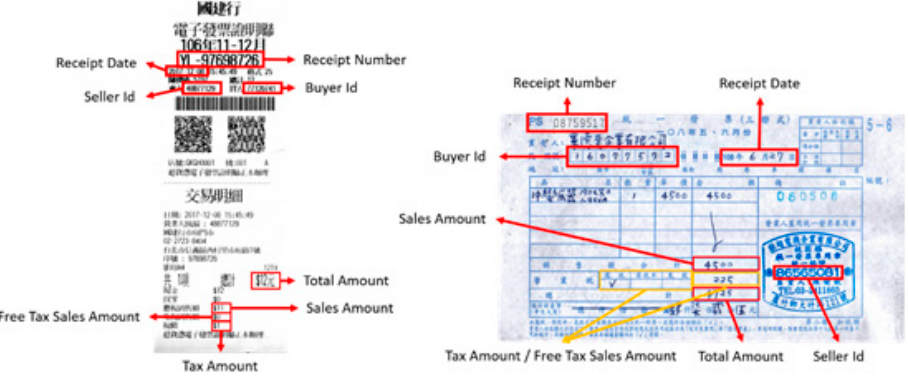
Figure 10. Receipt information required for tax filing .